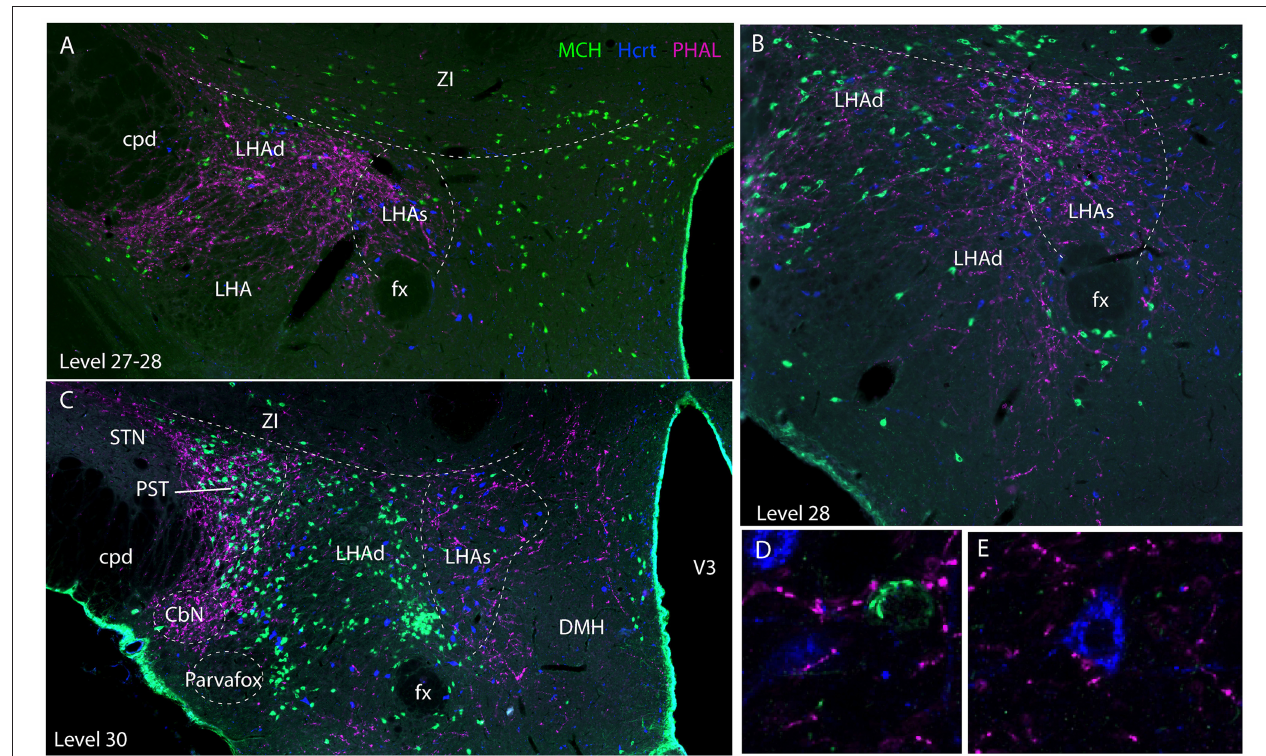
FIGURE 5 | Photomicrographs illustrating the co-distribution of PHAL axons, MCH and Hcrt cell bodies using a triple immunofluorescence procedure. (A–C) are low magnification pictures on sections at levels 27 (in fact better seen as inter-level 27/28), 28 and 30. Note the innervation of regions containing MCH and Hcrt cell bodies and corresponding to the dorsal and suprafornical regions of the LHA. However, the ZI, or the caudal perifornical regions (level 30) that are rich in MCH cell bodies but poor in Hcrt neurons are not innervated. By contrast at level 30, the PST that contains a dense group of MCH neurons is intensely innervated. (D,E) Higher magnification illustrations showing that buttons by PHAL axons could be seen close to MCH and Hcrt cell bodies. However, it seemed to be mostly en passant putative